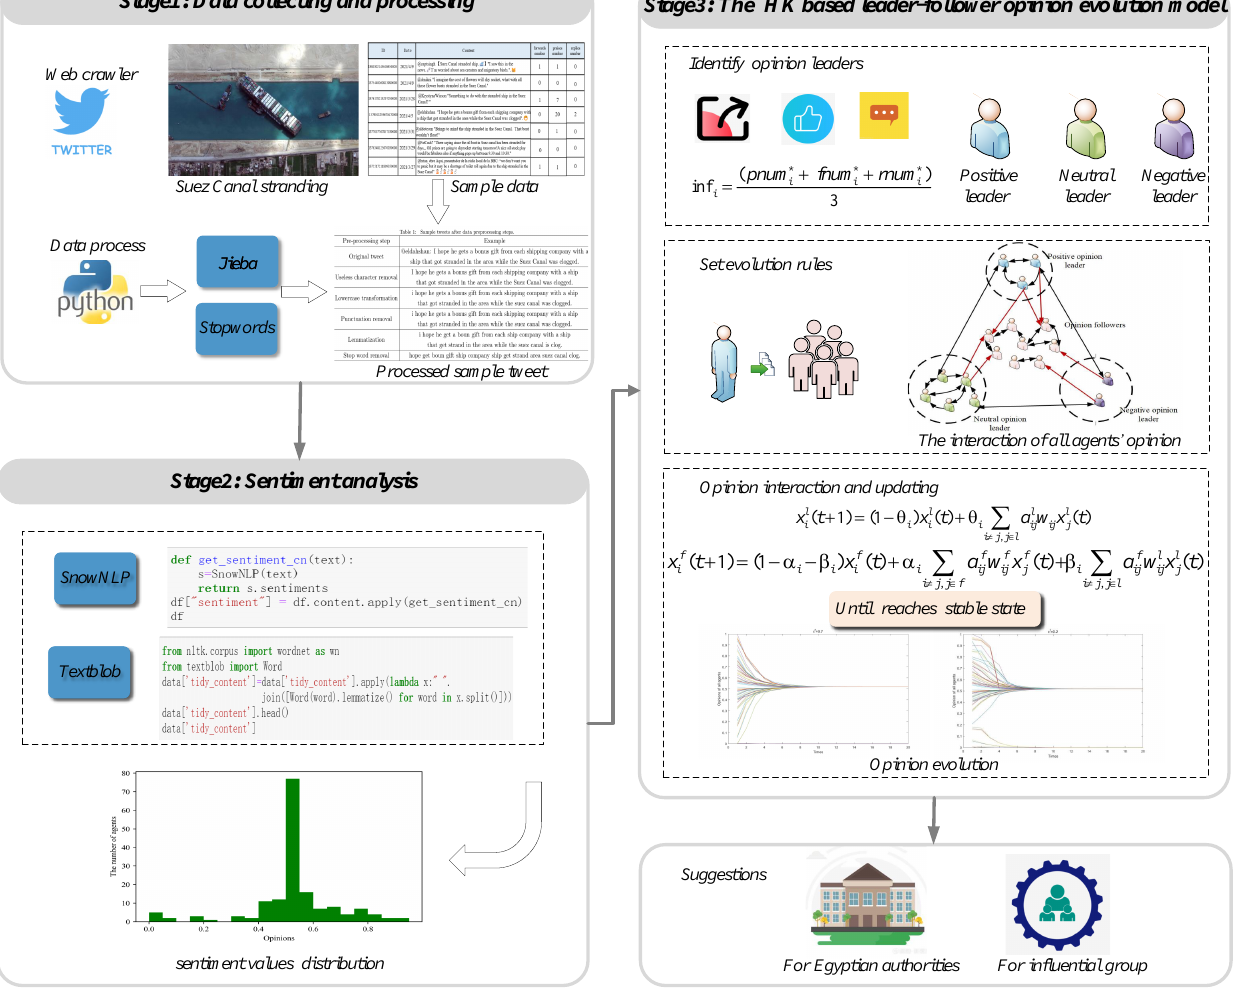
Figure 2. Research framework of the leader–follower opinion evolution model for online